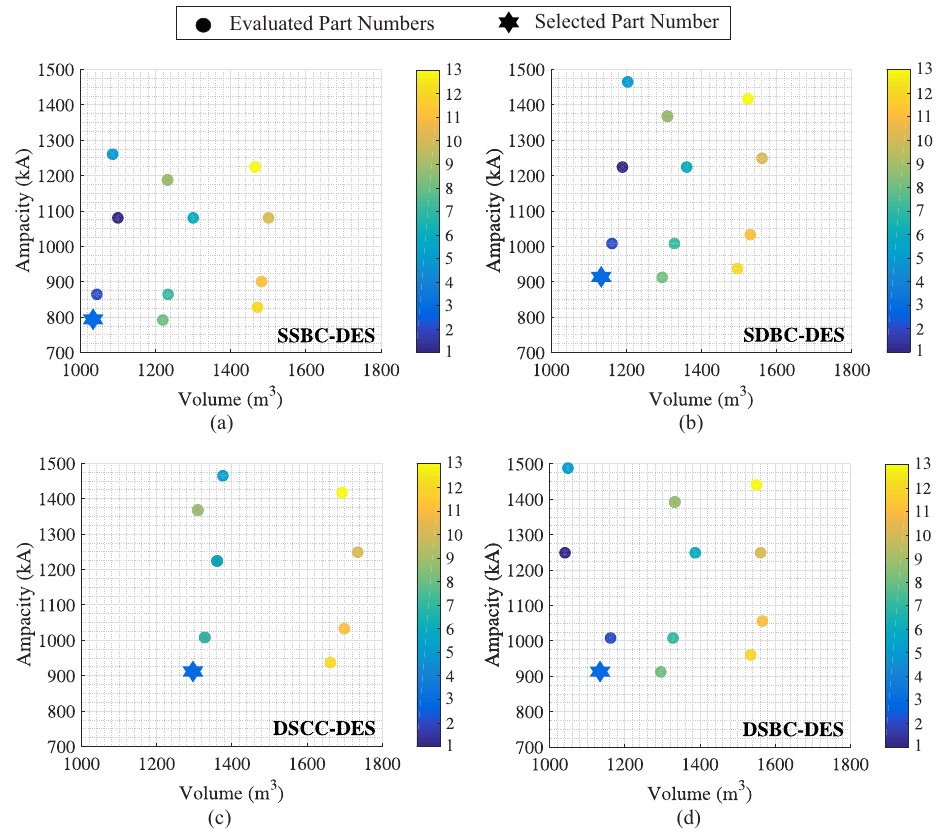
Figure 5. Ampacity versus volume map for DES topologies considering the SOC from 0% to